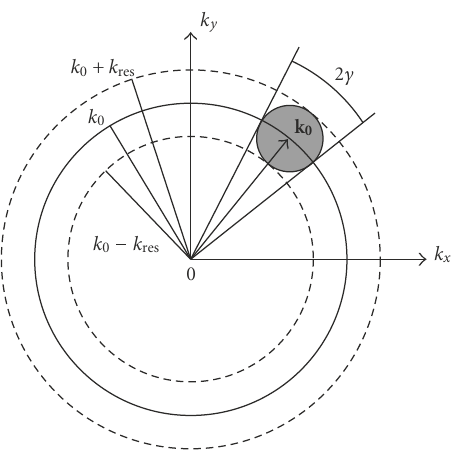
Figure 1: Slice of the 3D representation illustrating the optimiza- tion procedure: the power of the spatial filter is maximized in the sphere centered on k 0 (gray disk) and minimized elsewhere in the spherical crown included between radii k 0 − k res and k 0 + k res